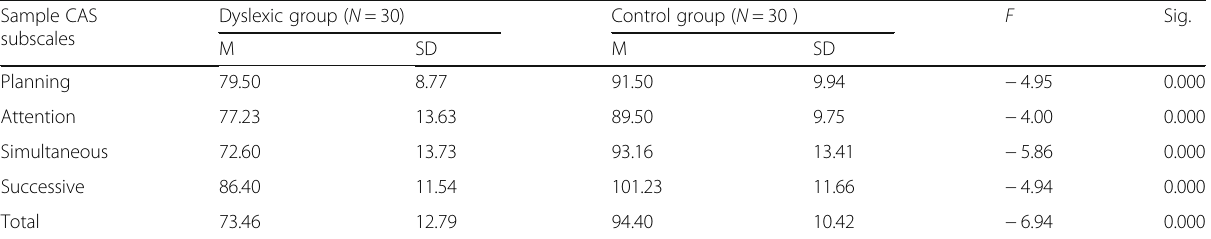
Table 4 Cognitive Assessment System: dyslexic vs. controls (middle childhood) Sample CAS Dyslexic group ( N = 30) subscales